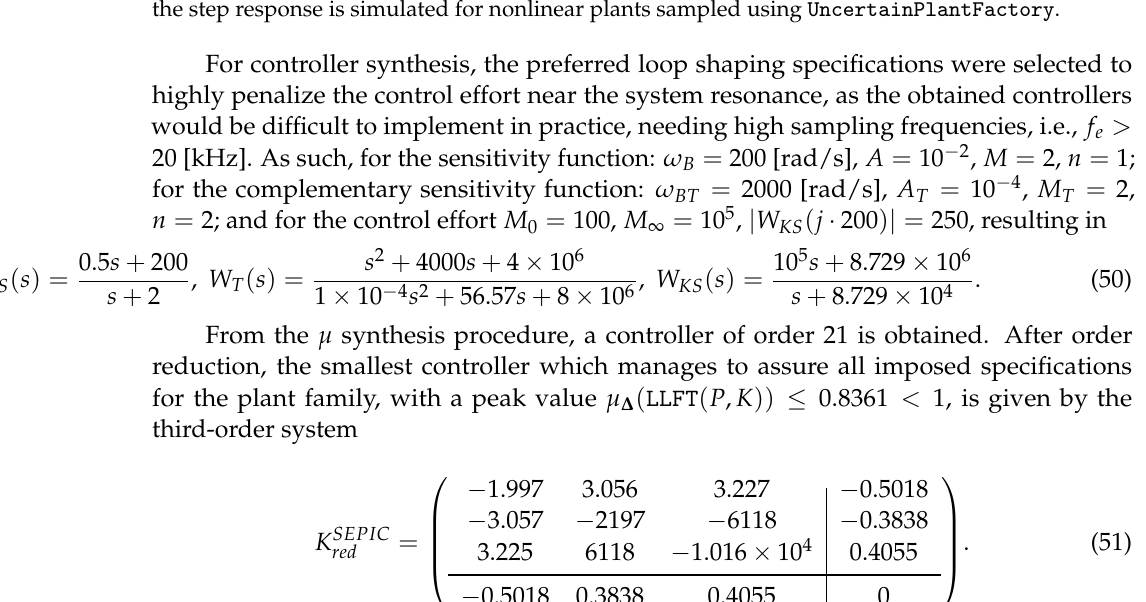
Figure 8. SEPIC multiplicative uncertainty set computation and open loop responses for the operating point with E = 300 [ V ] , R = 80 [ Ω ] , U R = 400 [ V ] : step and frequency response, pole-zero placement; the step response is simulated for nonlinear plants sampled using UncertainPlantFactory